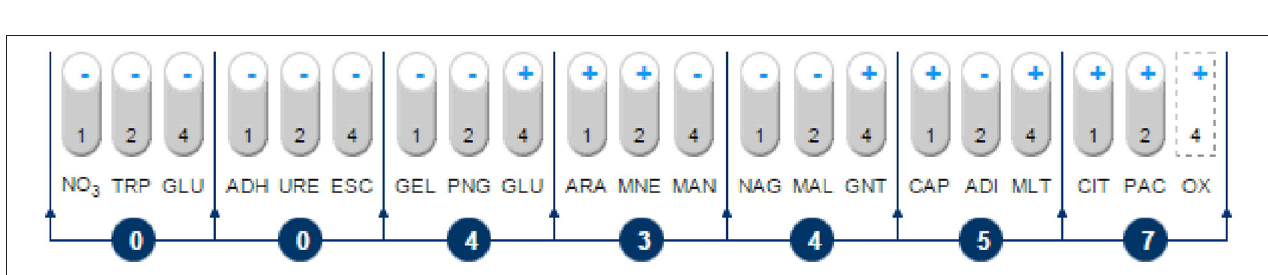
FIGURE 2 | Phylogenetic tree of a multidrug-resistant strain MC1 based on the neighbor-joining method. Bootstrap values from 1,000 replications are indicated at the branches. GenBank accession numbers are given in parentheses.